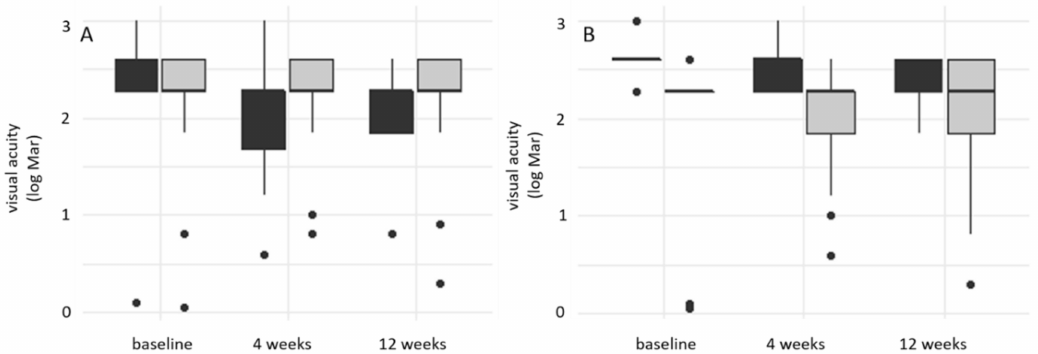
Figure 4. ( A ) box plot of BCVA (log Mar) in patients with p-MLM sign (gray) and without (dark) (visit 1: p = 0.0012; visit 2: p = 0.001; visit 3: p = 0.392); ( B ) box plot of visual acuity (log Mar) in patients with spot sign (gray) and without (dark) (visit 1: p = 0.548; visit 2: p = 0.357; visit 3: p =